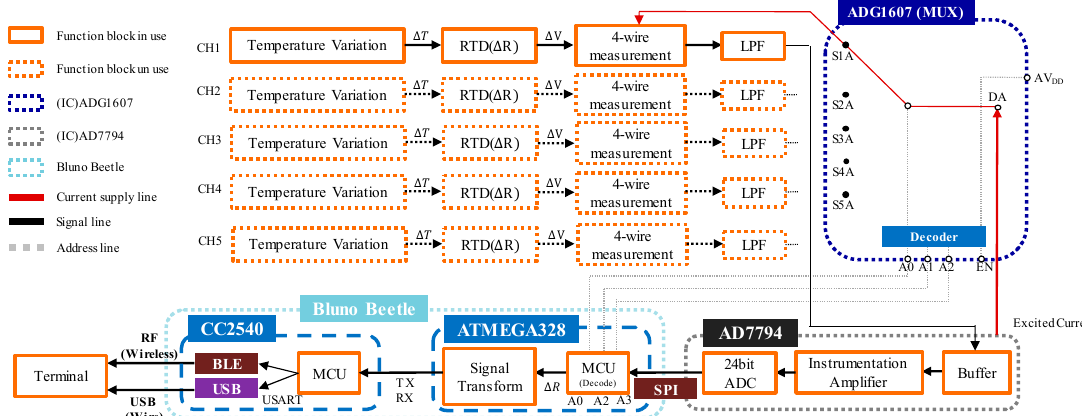
Figure 1. Functional block diagram of the temperature sensor and wireless transmission module (TSWTM).